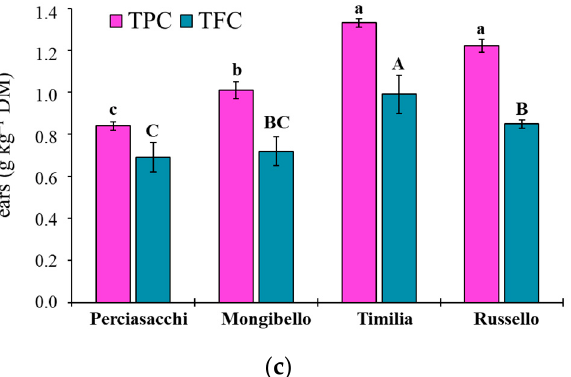
Figure 6. Total polyphenol (TPC) and total flavonoid (TFC) content in root ( a ), stem ( b ) and ear ( c ) extracts of durum wheat genotypes. Different letters (a–c) indicate significant differences among genotypes for the TPC ( p ≤ 0.05). Different letters (A–C) indicate significant differences among genotypes for the TFC ( p ≤ 0.05). Bars indicate ± standard error. DM: dry matter.